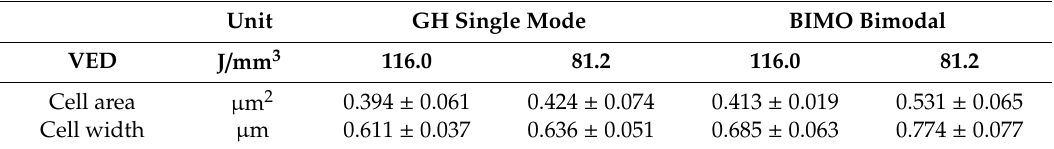
Table 5. Measured cell area and cell width of cellular structure observed in single-mode and bimodal powder size distribution SLM-manufactured at VED of 81.2 and 116 J / mm 3